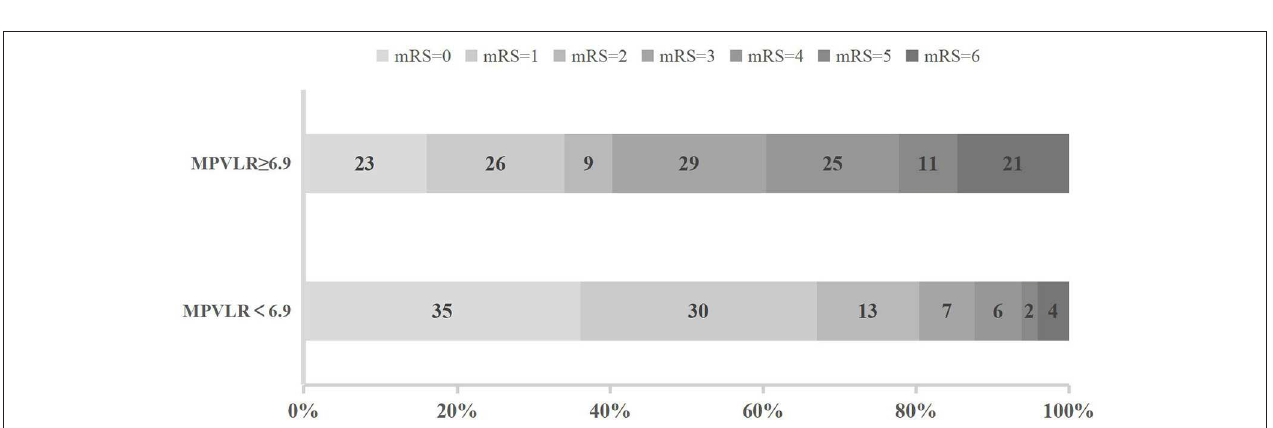
FIGURE 2 | Functional outcomes at 3 months in groups stratified according to the cutoff value of mean platelet volume-to-lymphocyte ratio (MPVLR) at admission.